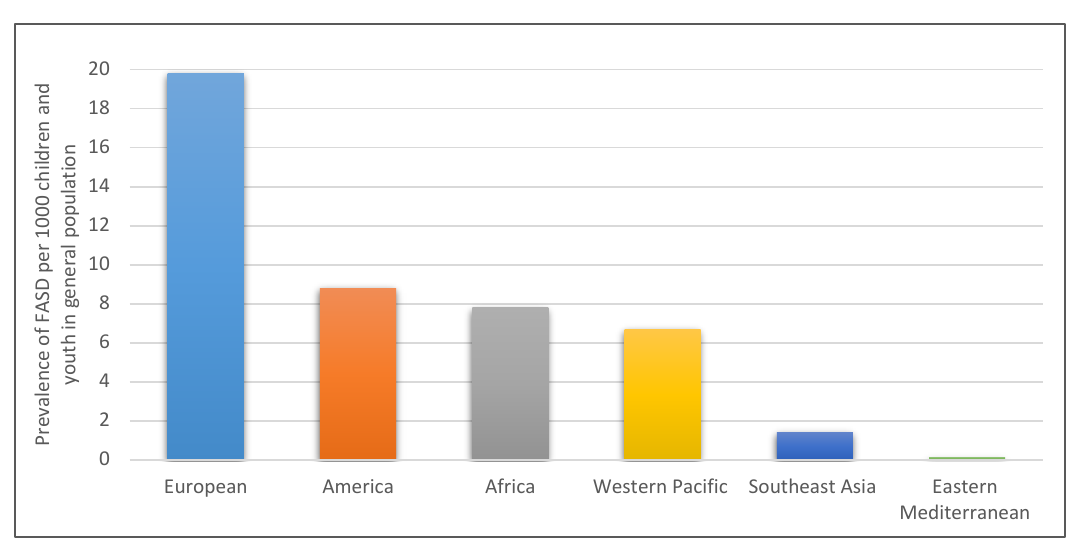
Figure 1. Prevalence of fetal alcohol spectrum disorder (FASD) by region.